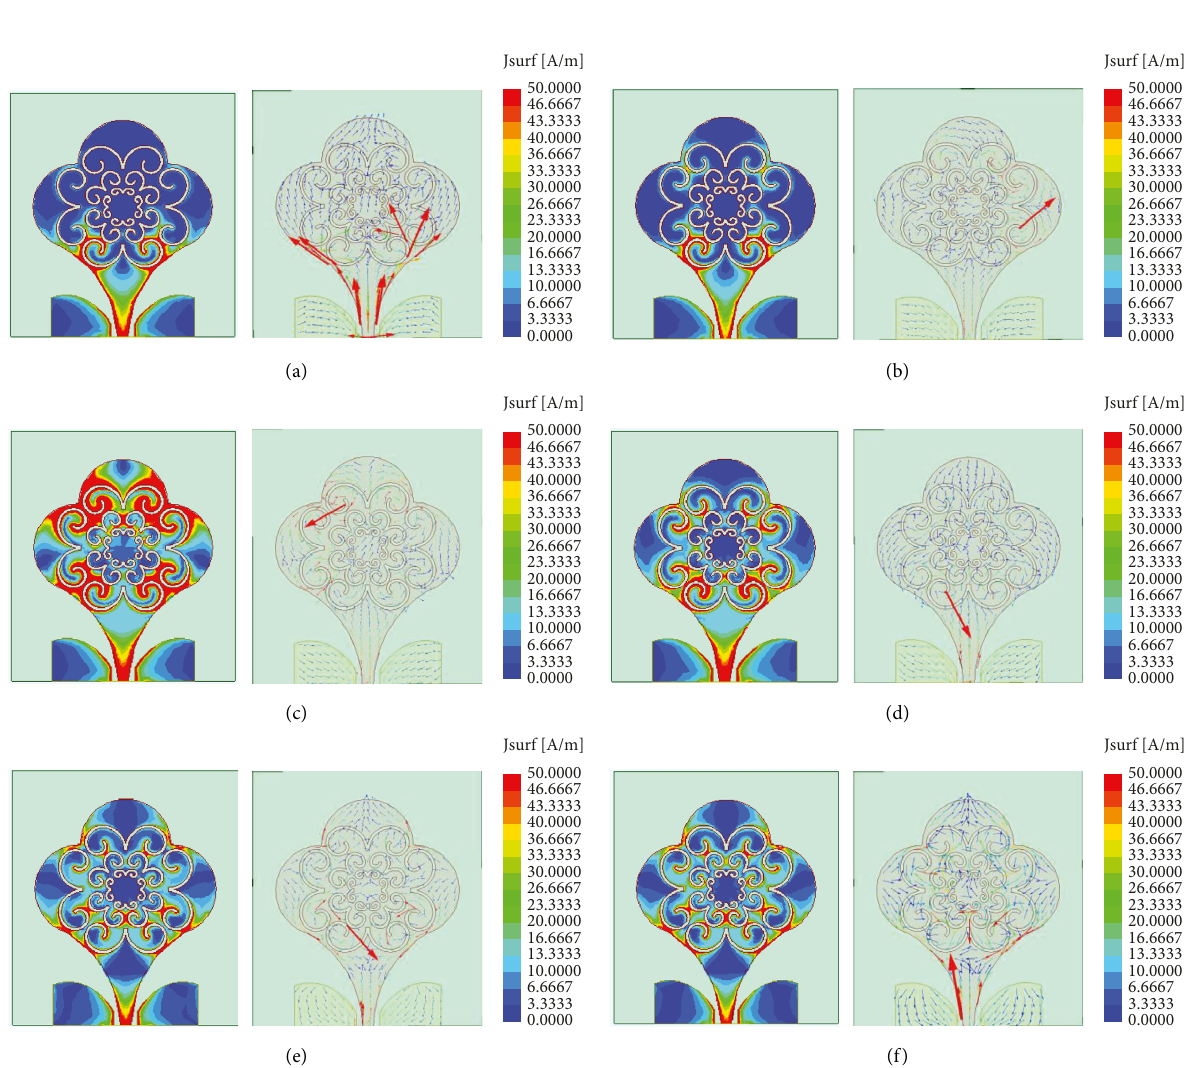
Figure 8: Current amplitude and vector distribution of the antenna at (a) 2.25GHz, (b) 2.5GHz, (c) 3.1GHz, (d) 3.55GHz, (e) 5.7GHz, and (f) 6